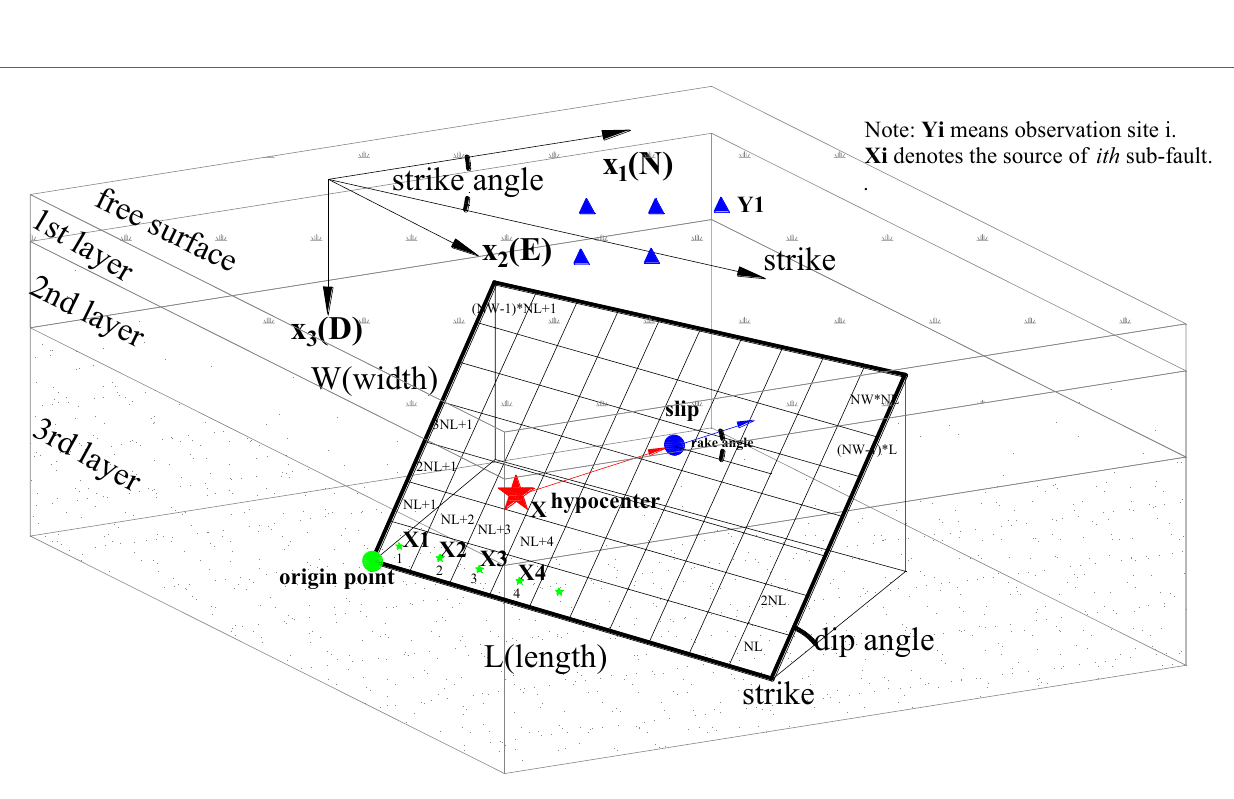
FigUre 5 | rupture model and parameters